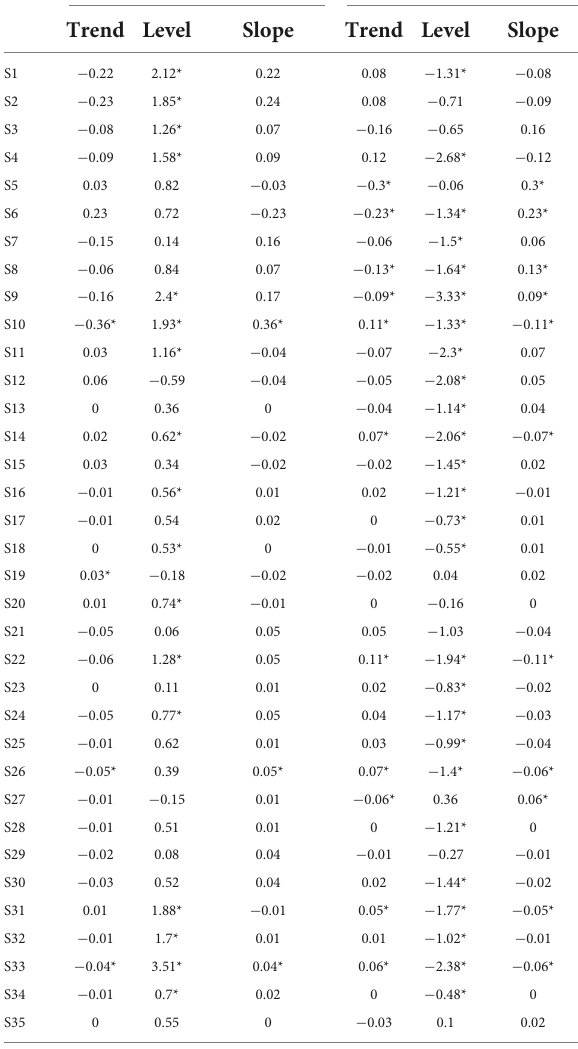
TABLE 4 Piecewise regression analyses for the 35 single cases for both dependent